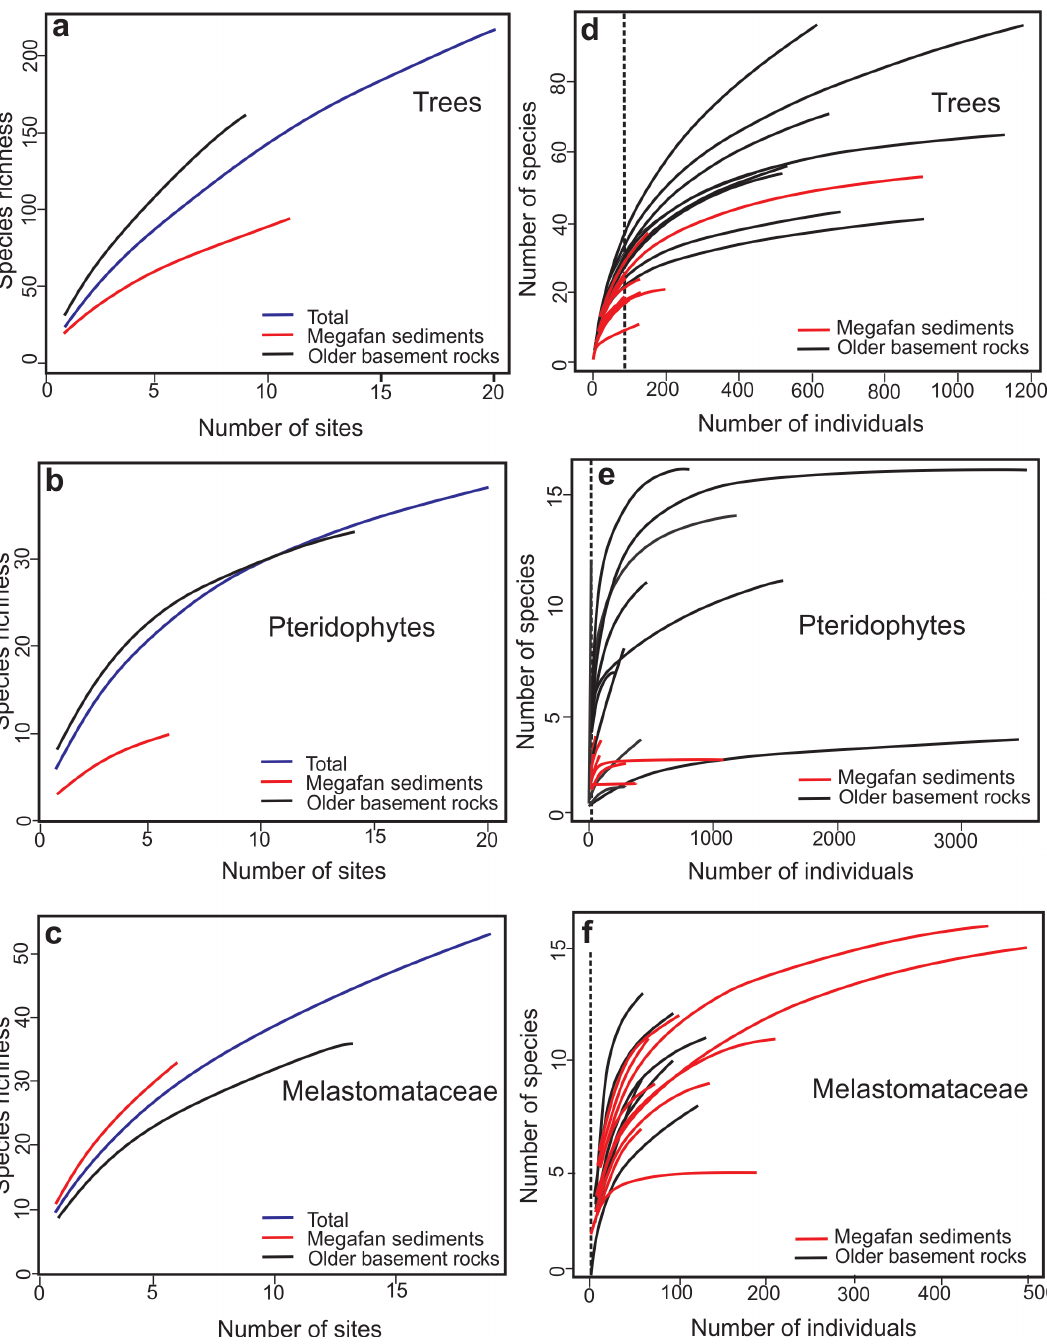
Figure 6 - Curves of accumulation and rarefaction of species for the plots inventoried in the Viruá megafan. a-c ) Curves of accumulation of species with the inventoried sites added to the sample in a random order, after having reduced the number of individuals in any plot. Separate species accumulations curves were traced for each kind of environment and for both combined. d-f ) Rarefaction curves with the number of expected species showed for different numbers of individuals sampled. Each line represents one plot and the gray levels (or colors in the online version) indicate whether the plot was located in megafan sediments or basement rocks. the vertical dashed line indicates the smallest number of individuals in any plot (86 for trees; 13 for pteridophytes; 1 for